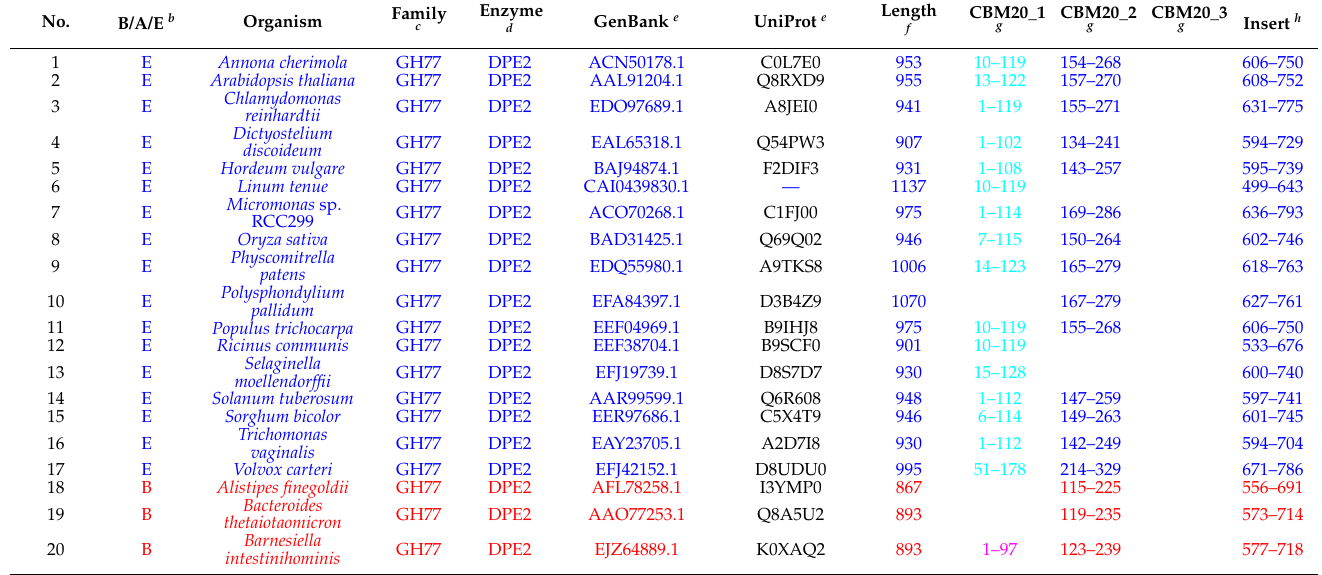
Table 1. The CBM20s originating from DPE2s, various other CAZymes, and related enzymes used in the present study a .